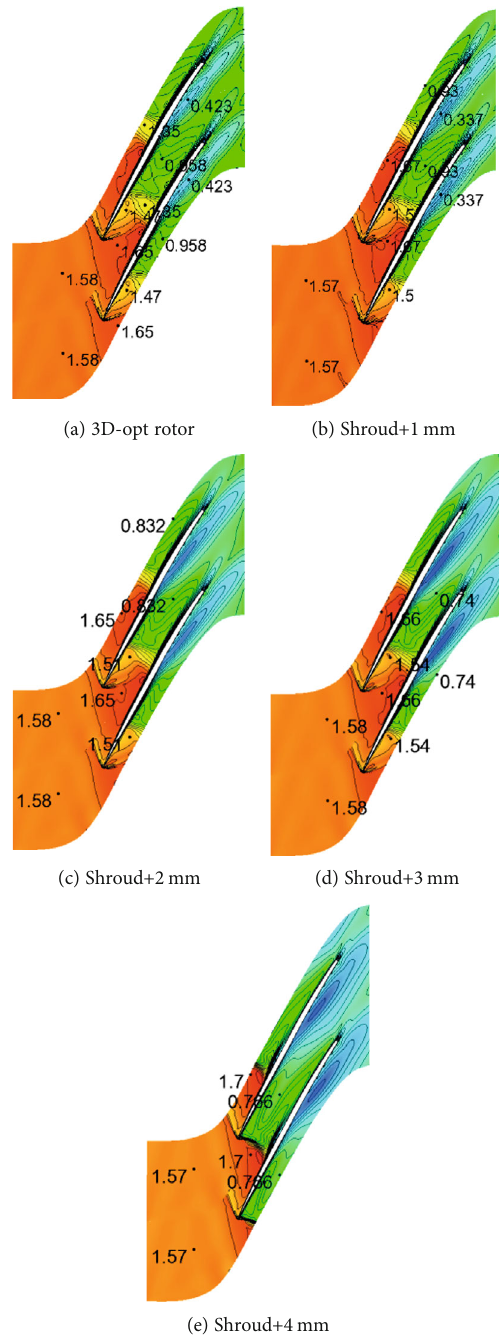
Figure 17: Mach number contours of 90% span at the near-stall